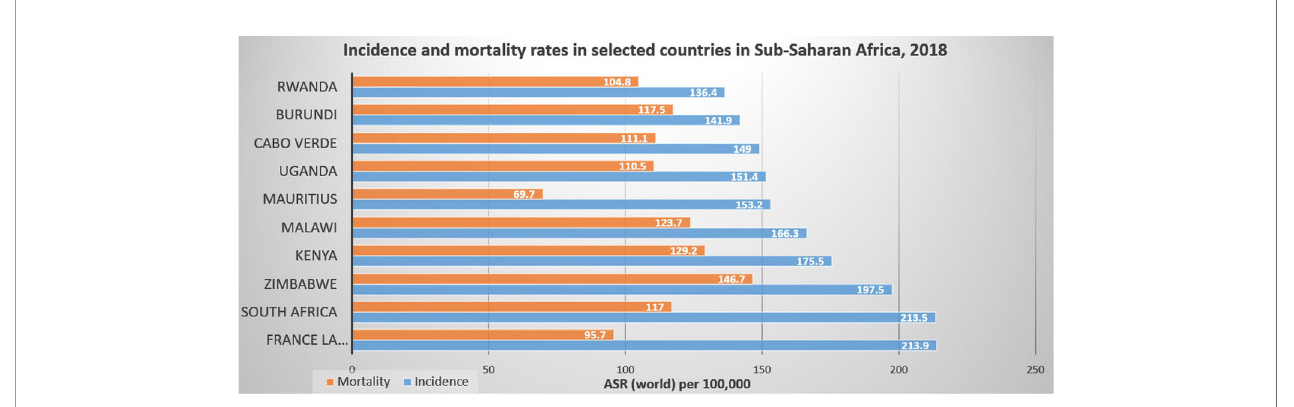
FIGURE 5 | Incidence and mortality rates in selected countries in Sub-Saharan Africa, 2018 (3). Reproduced from "The Cancer Atlas,"